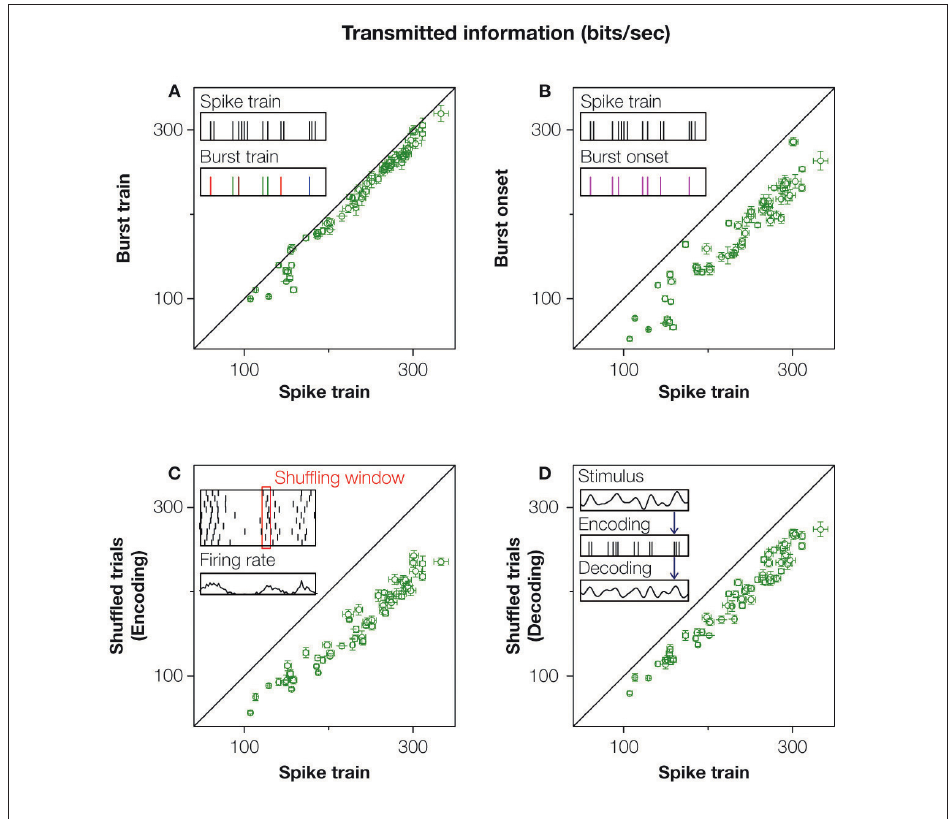
Figure 3 | The information rate carried by manipulated spike trains, for all recorded bursting cells. x-axis: original response. y-axis: manipulated response. In all cases, information rates were calculated using the direct method (Strong et al., 1998), with the error estimations from Montemurro et al. (2007b). ( A ) The spike train is parsed into a sequence of bursts that are only distinguished by their spike count, such that their inner structure is neglected. Inset: green, red, blue and brown symbols in the burst train represent bursts containing 1, 2, 3 or 4 action potentials in the original spike train, respectively. The sequence of bursts contains 94% of the information of the full spike train. ( B ) If the same symbol is used to represent bursts of different lengths, then distinctions between different stimulus features are no longer possible (see inset). Only temporal information referring to the timing of each feature remains. This leads to a 26% reduction of the original information (22%, if compared to the information transmitted by the burst train). ( C ) If trials within each fixed time bin are shuffled, all within-trial temporal correlations are destroyed, though the time-dependent firing rate is preserved. As a consequence, the information drops by 32%. ( D ) If the stimulus is decoded from the spike train (see inset) without taking temporal correlations into account, the information is reduced by